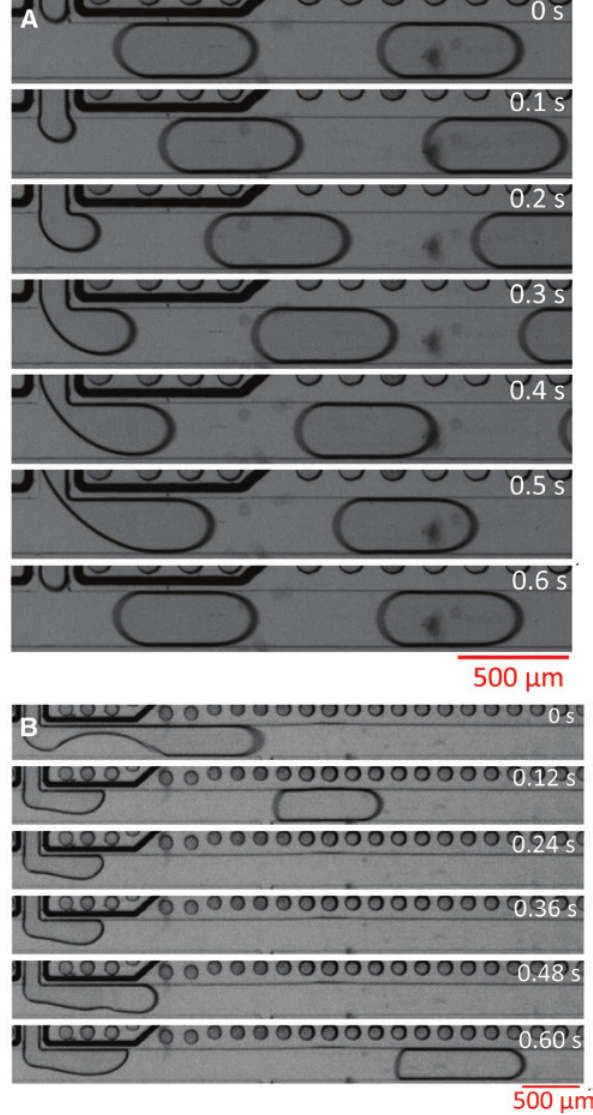
Figure 3: Flow dynamics of the gas/liquid segmented flow: the gas phase is argon; the liquid phase is 2-propyl alcohol (A) and deionized water